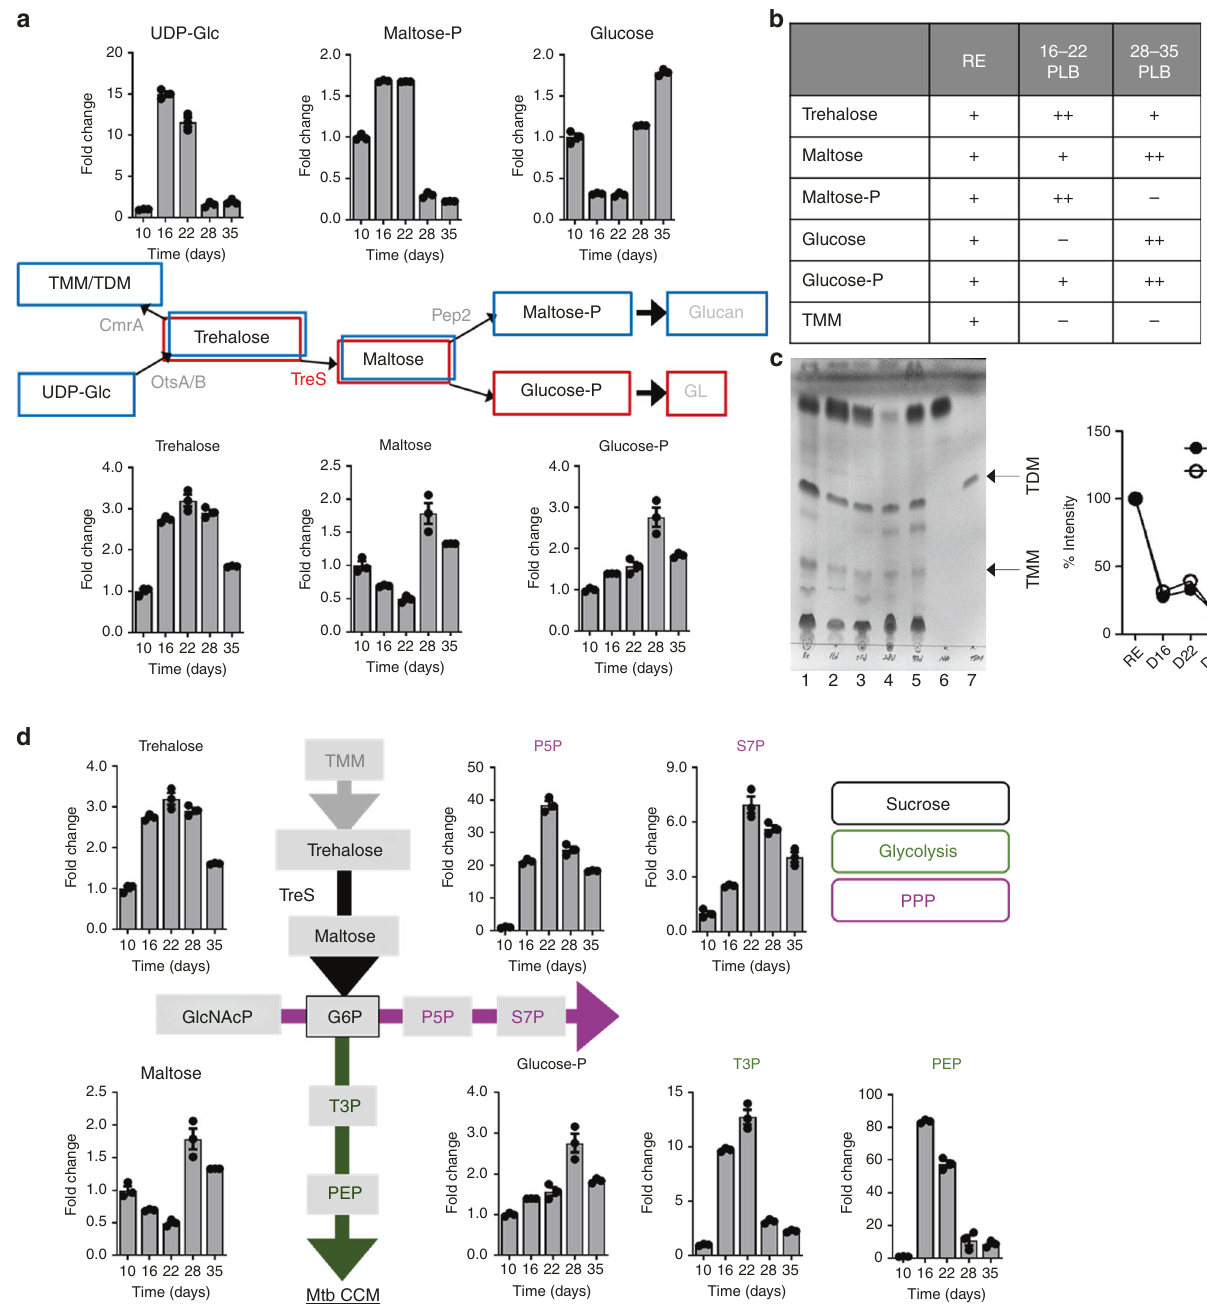
Fig. 1 Mtb PLB-speci fi c remodeling of trehalose metabolism, glycolysis, and the pentose phosphate pathway. a , d Intermediates of trehalose metabolism were as described in Supplementary Fig. 4. Intrabacterial pool sizes of Mtb intermediates in trehalose metabolism, glycolysis, and the pentose phosphate pathway in PLB harvested from mycobacterial bio fi lm culture at days 10, 16, 22, 28, and 35. Total bar heights indicate the intrabacterial pool sizes relative to those of PLB at day 10. Blue-boxed metabolites denote the carbon fl ux of the replicating state and red-boxed metabolites denote the carbon fl ux of PLB at day 28. UDP-Glc, uracil diphosphate-glucose; maltose-P, maltose phosphate; P5P, pentose 5-phosphates; S7P, sedoheptulose 7-phosphates; G6P, glucose 6-phosphates; T3P, triose 3-phosphates (dihydroxyacetone phosphate and glyceraldehyde phosphate); PEP, phosphoenolpyruvate. b Major changes in time-course PLB metabolomics (one plus, levels in replicating state; two pluses, increased; one minus, decreased). c Analysis of the extractable trehalose monomycolate (TMM), trehalose dimycolate (TDM), and free mycolic acids from PLB at the same time points as metabolome extraction. Equal amounts of total cellular lipids were run in the solvent system (chloroform:methanol:H 2 O, 90:10:1; v/v/v) (left panel) and TMM/TDM intensity (density) was monitored by ImageJ software (right panel). The labeled band shown in the TLC corresponds to the R f of a TMM, TDM, or mycolic acid standard. Lane 1, replicating; Lane 2, day 16 PLB; Lane 3, day 22 PLB; Lane 4, day 28 PLB; Lane 5, day 35 PLB; Lane 6, standard mycolic acid; Lane 7, standard TDM. d Black font metabolites are members of sucrose metabolism, green font metabolites are members of glycolysis, and magenta font metabolites are members of the pentose phosphate pathway (PPP). CCM, central carbon metabolism. All values are the average of two independent biological duplicates ± s.e.m. Source data are provided as a Source Data fi le